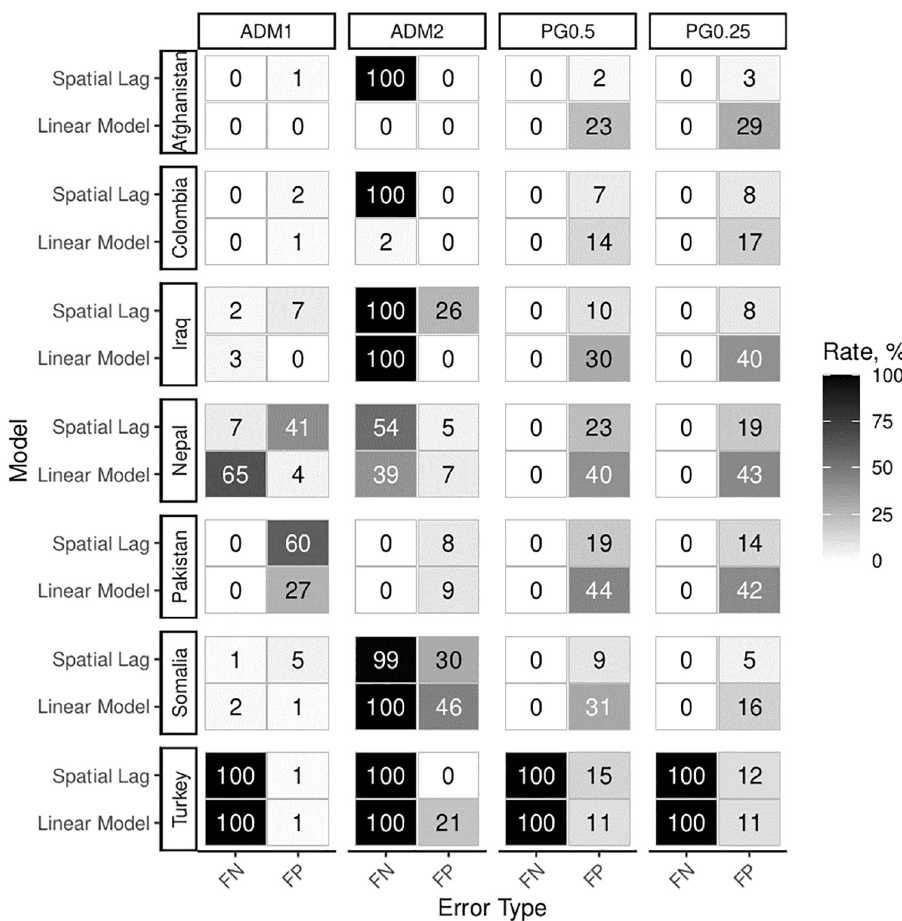
Fig 8. Experiments 2a and 2b (diffusion scenario, with and without causal effect) analyzed with a simple linear model as well as a spatial lag model. All models include area